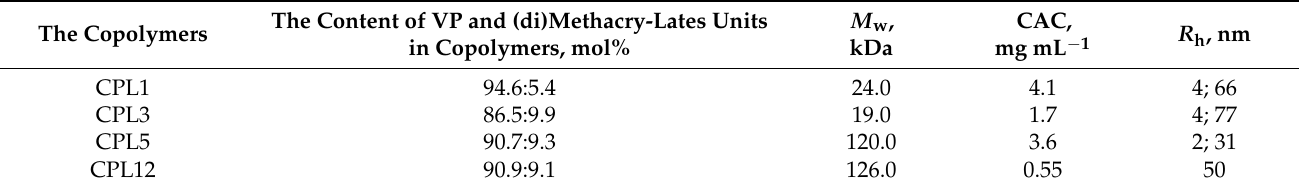
Table 1. Physicochemical characteristics of the VP